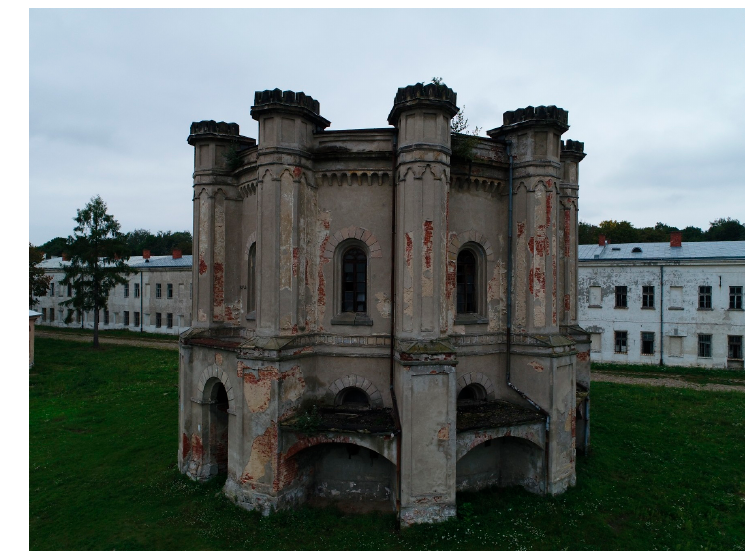
Figure 3. Study area.